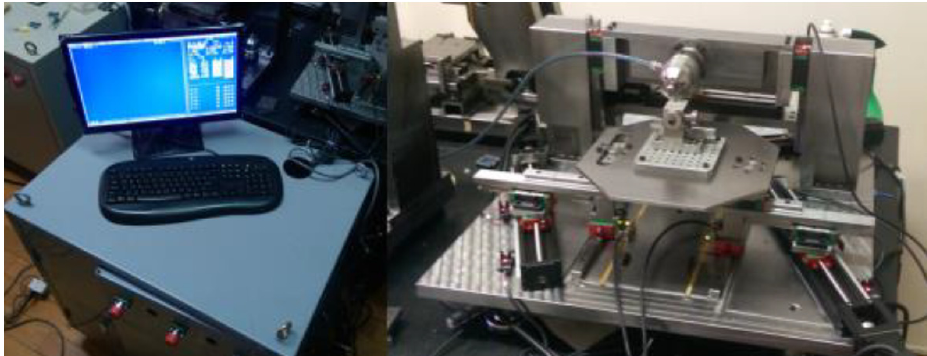
Figure 16. Prototype of horizontal micromachine tool with co-planar multi-DOF.